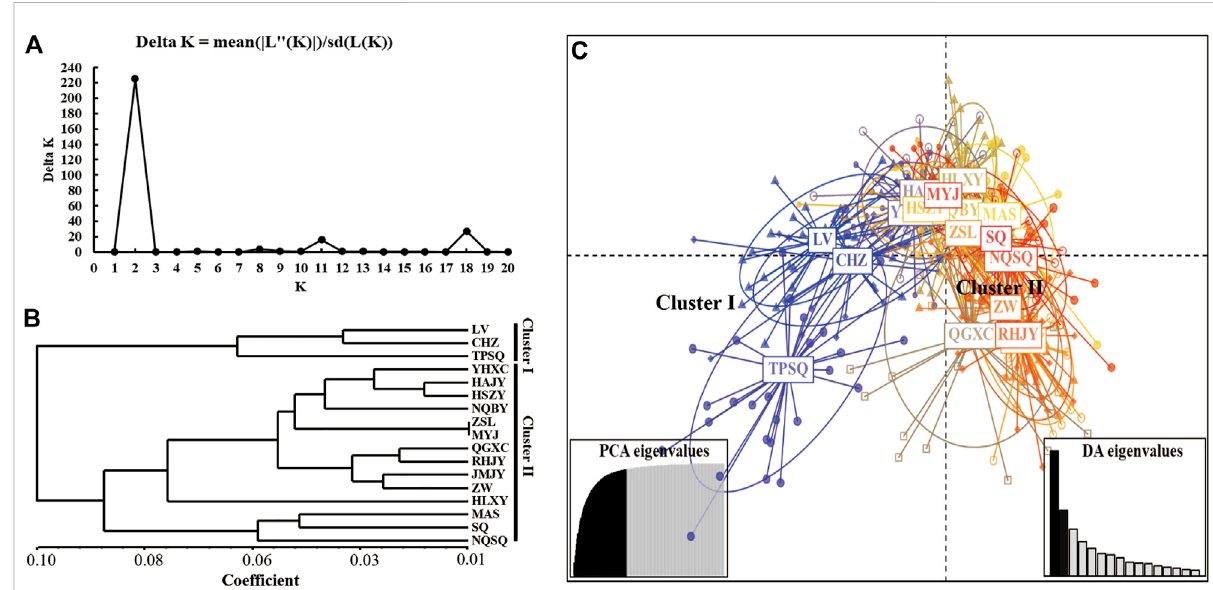
FIGURE 2 The population structure analysis of all 17 Ae. albopictus populations based on 9 microsatellite loci. (A) K values assessed via Evanno et al. ‘ s Δ K methods; (B) Bayesian clustering analysisof all Ae. albopictus populations; (C) DAPC analysisof all Ae. albopictus populations, and 86.4% of variation was explained by 50 PCs.